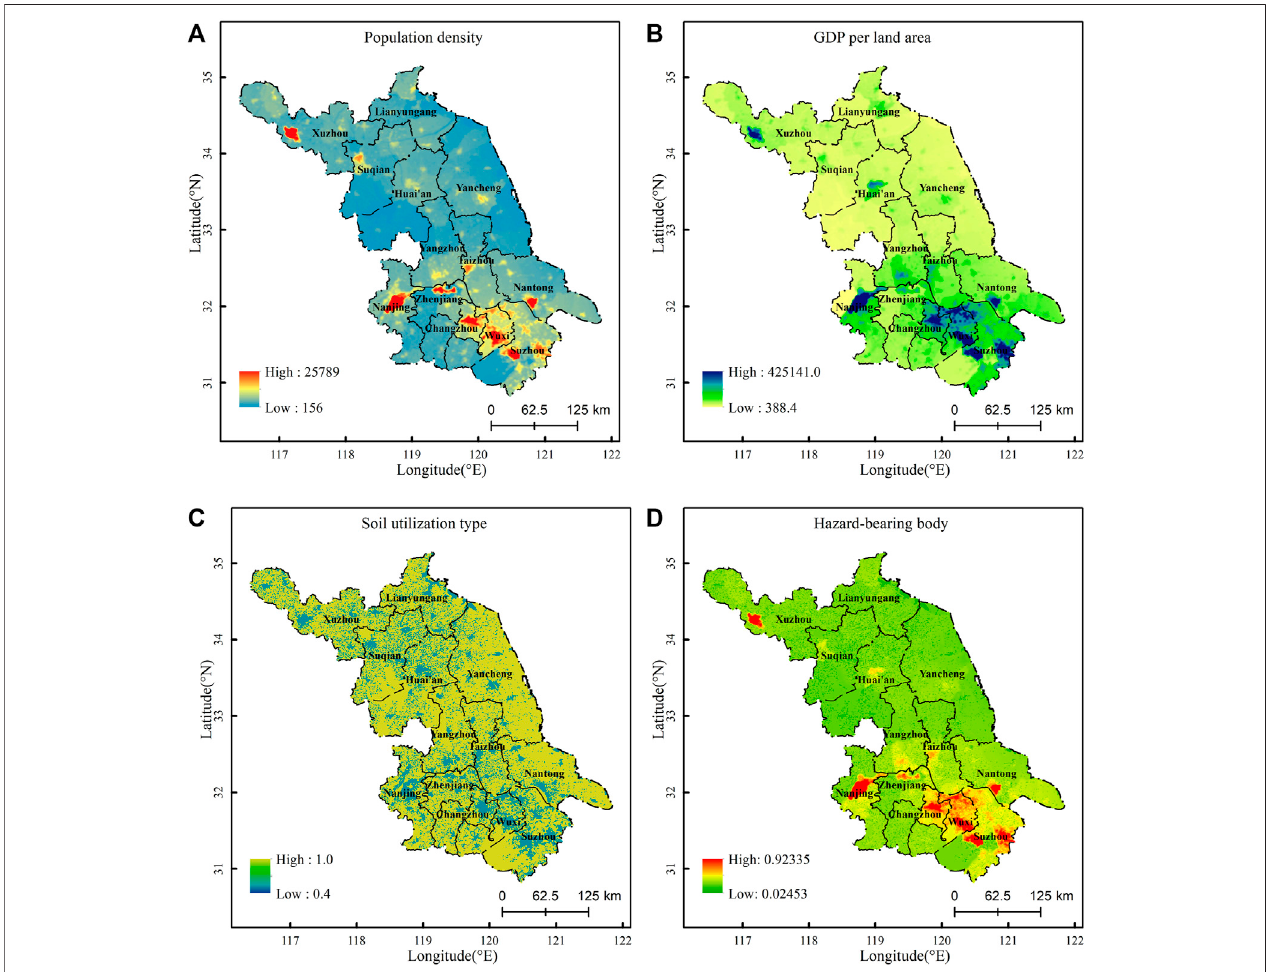
FIGURE5| Frangibilityoflightninghazard-bearingbodyinJiangsu. (A) Populationdensity,unit: person/km 2 ; (B) GDPvalueoftheregion,unit: tenthousandYuan/ km 2 . (C) Soil utilization type. (D) Hazard-bearing body.